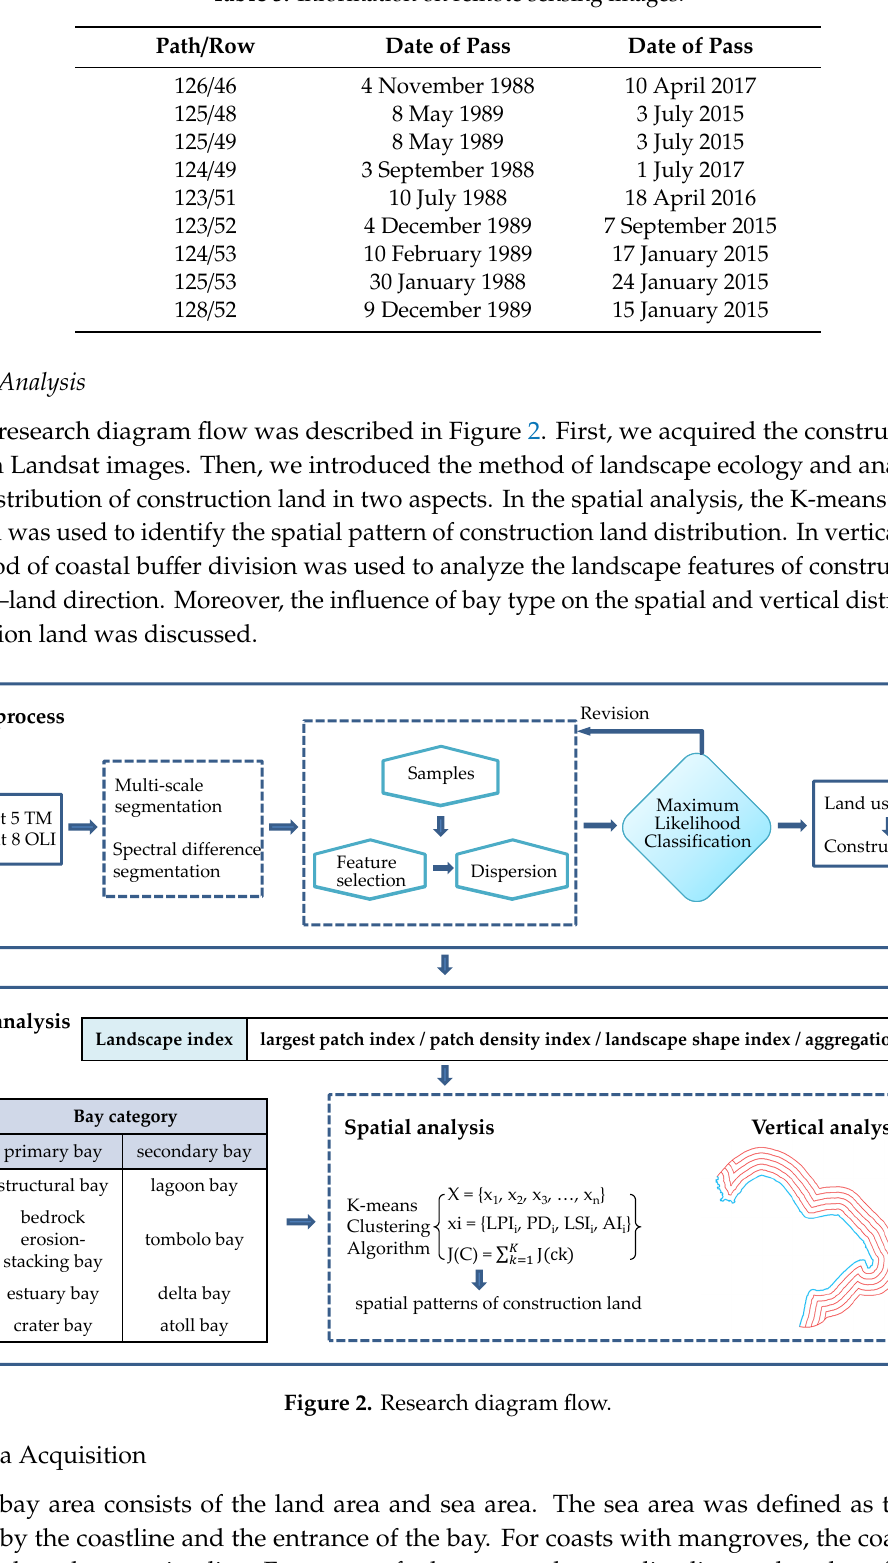
Table 3. Information on remote sensing images.